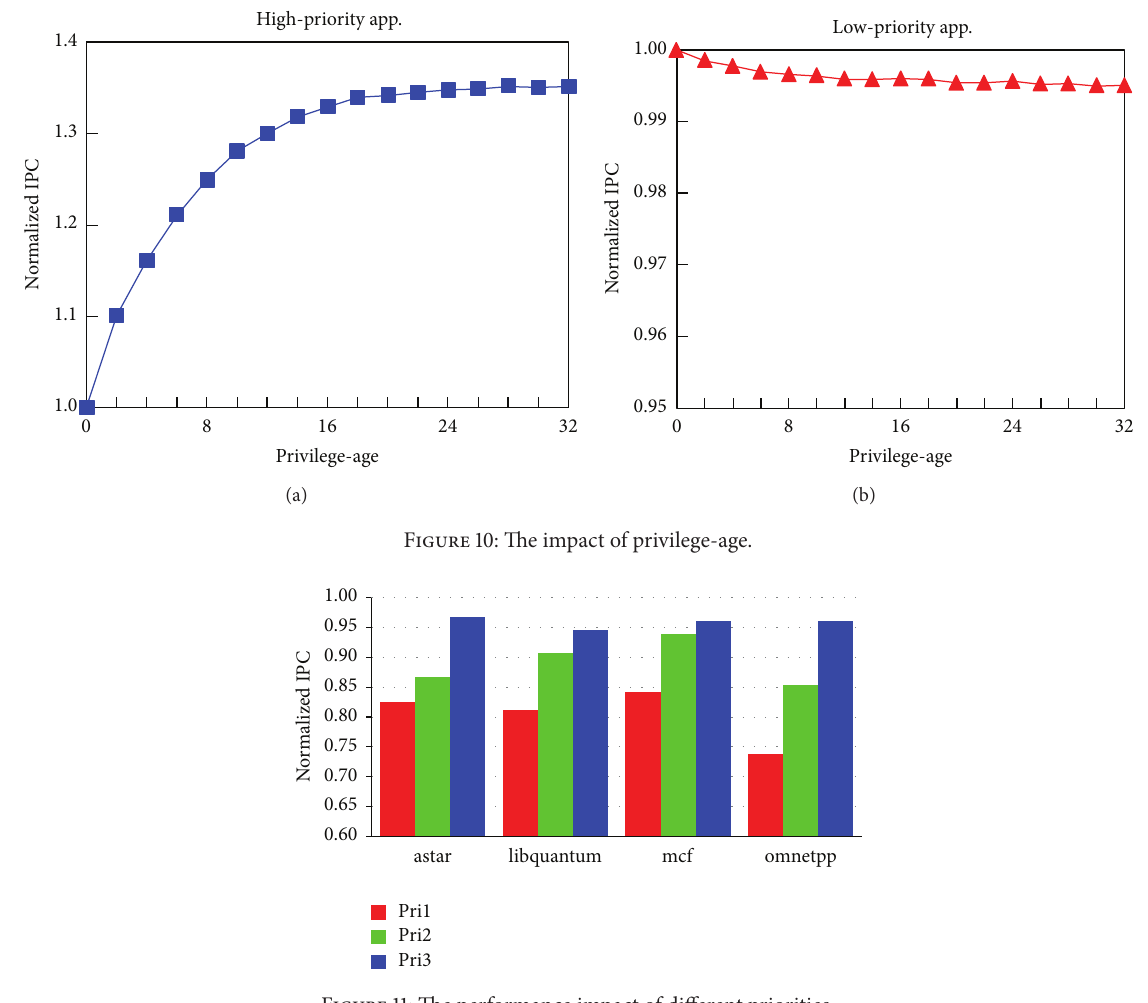
Figure 10: The impact of privilege-age.